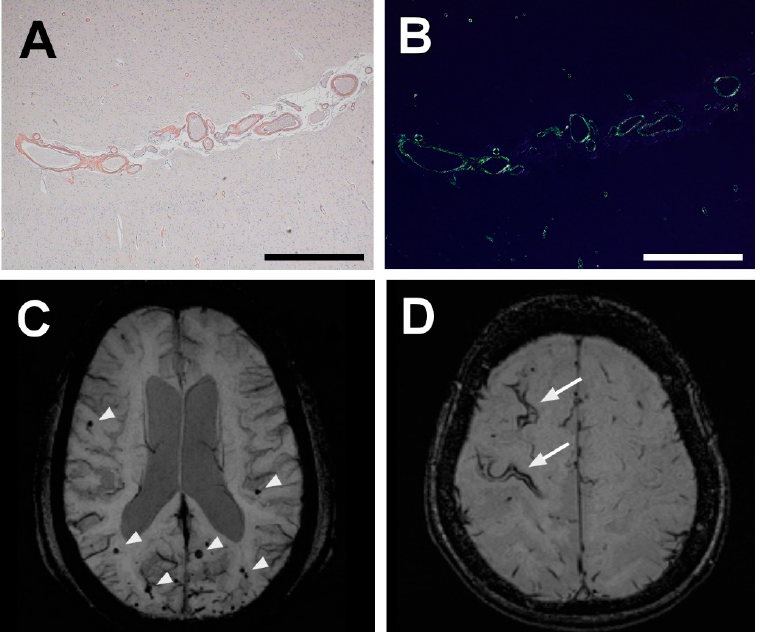
Figure 1. Histopathological and radiological imaging of CAA (cerebral amyloid angiopathy). Rep- resentative histopathological images from a patient with severe CAA. Congo red-positive lep- tomeningeal arteries ( A ) and those same arteries viewed under polarized light ( B ). SWI (susceptibility-weighted imaging) MRI shows a strictly lobar distribution of lobar microbleeds (arrowheads) ( C ). SWI shows cSS (cortical superficial siderosis) as hypointense curvilinear signals along the cortical gyri (arrows) ( D ). Scale bars = 1 mm.